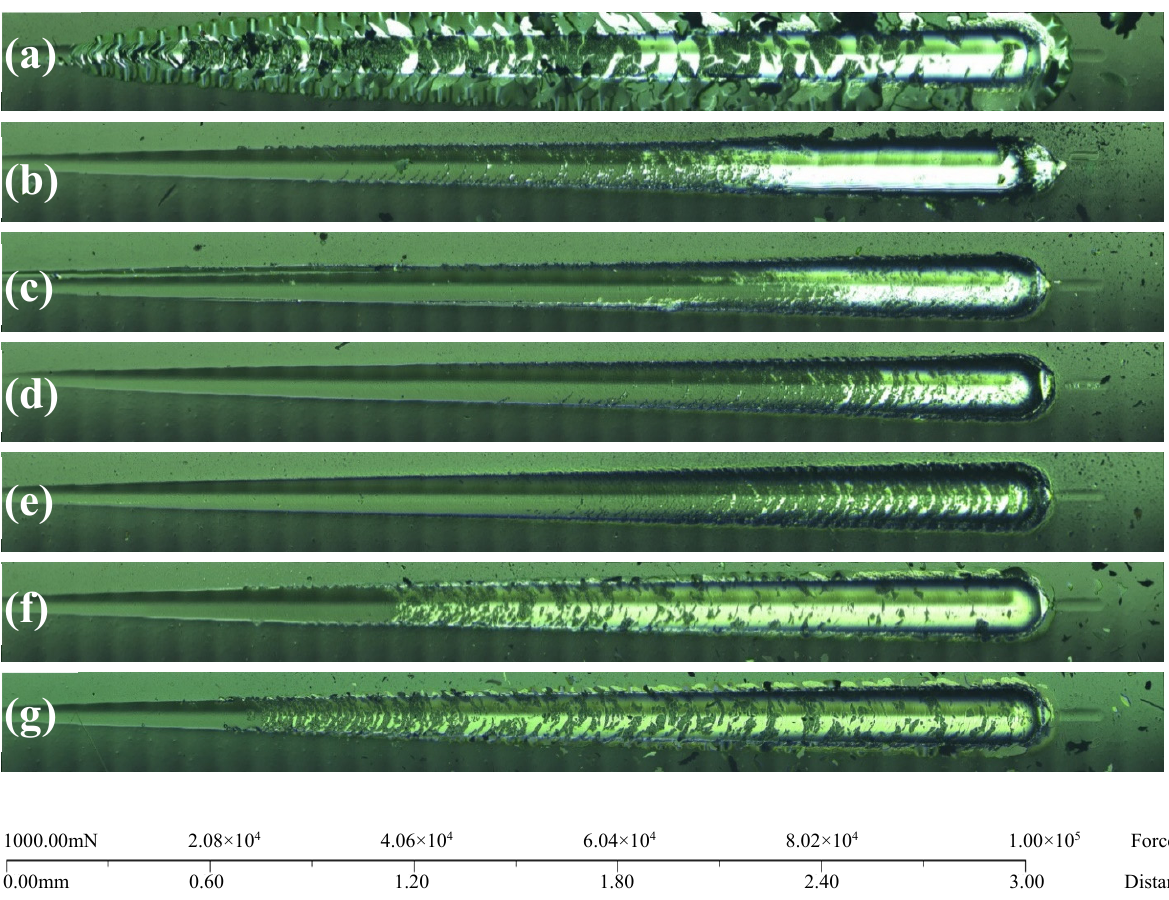
Figure 9. Scratch images of the CrC/a-C:H coatings with the CrC interlayer deposited at ( a ) 0, ( b ) 5, ( c ) 10, ( d ) 15, ( e ) 20, ( f ) 25, and ( g ) 30 sccm C 2 H 2 flow rates.